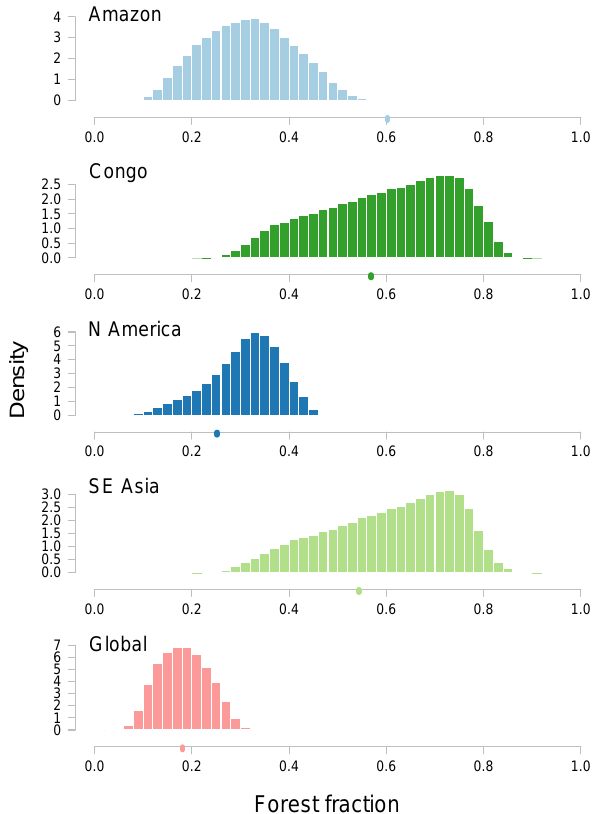
Figure 13. Histograms of emulated simulator output using credi- ble estimates for observational uncertainty, a simulator discrepancy term for the Amazon, and credible discrepancy